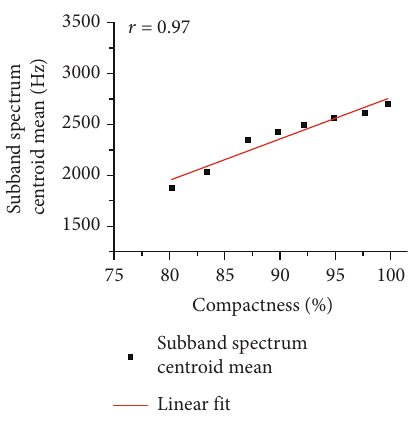
Figure 15: Correlation diagram of the mean value of the centroid of the subband spectrum and the soil mass with di ff erent compaction degrees under the action of 35(L) N hammering force.